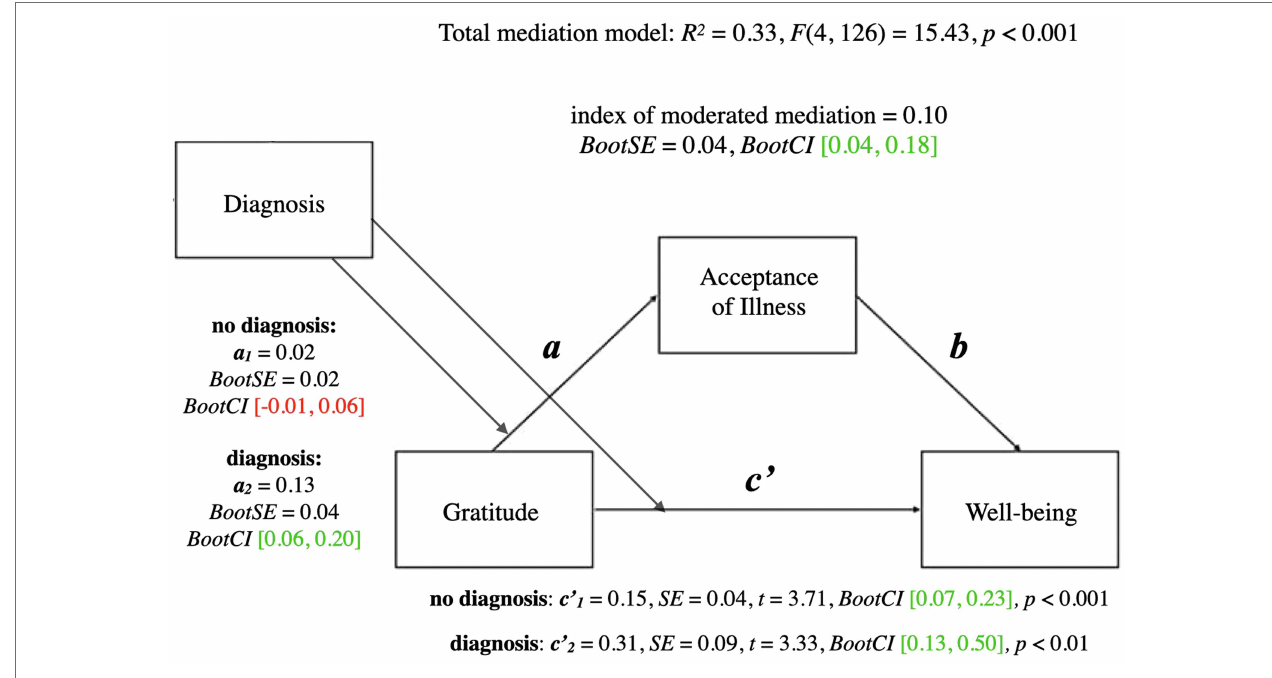
FIGURE 4 | Moderated mediation model for gratitude and wellbeing with diagnosis as moderator. a, conditional indirect effect of gratitude on wellbeing through acceptance of illness; c', conditional direct effect of gratitude on wellbeing index of moderated mediation = difference between conditional indirect effects; CI marked green indicate significance; red – lack of